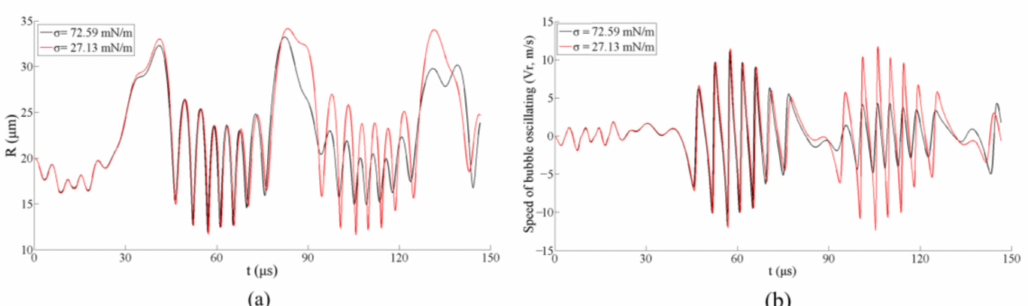
Figure 5. Comparison of the theoretical and experimental results for a free-field bubble in an ultrasonic field in the pure water ( R 0 = 20 µ m); ( a ) results of the bubble radius and ( b ) the bubble oscillating speed.